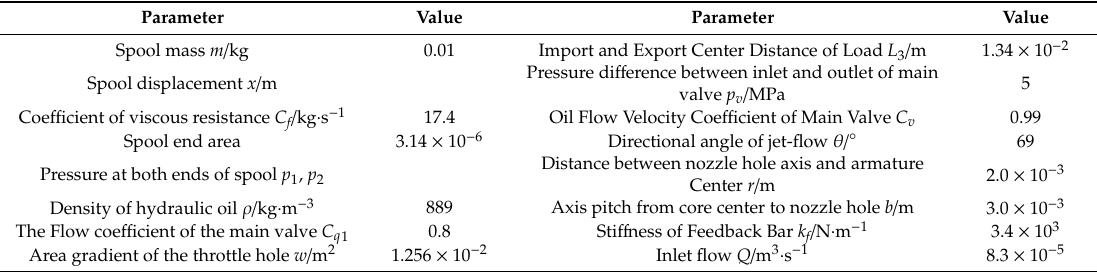
Table 5. Parameters for mathematical modeling of servo valves.